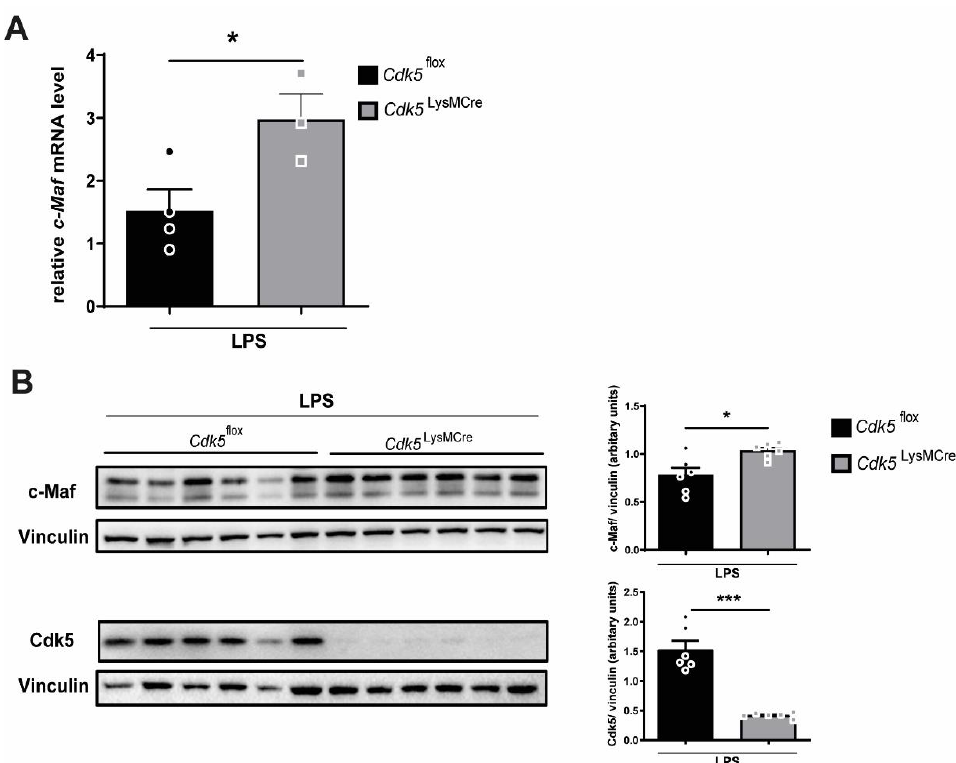
Figure 2. Genetic Cdk5 deletion in bone marrow-derived macrophages increases c-Maf after LPS stimulation. BMDMs from Cdk5 flox and Cdk5 LysMCre mice were stimulated with PBS (Co) or LPS (100 ng/mL) for 4 h and ( A ) relative c-Maf mRNA expression was measured by qRT-PCR and ( B ) c-Maf protein (42 kDa), Cdk5 (30 kDa) and vinculin (117 kDa) as loading control were detected by immunoblot (left) and quantified (right). Results are depicted as mean ± SEM. Statistical analysis were performed by a normality test, followed by a two-tailed unpaired Student’s t test. * p < 0.05; *** p < 0.001.